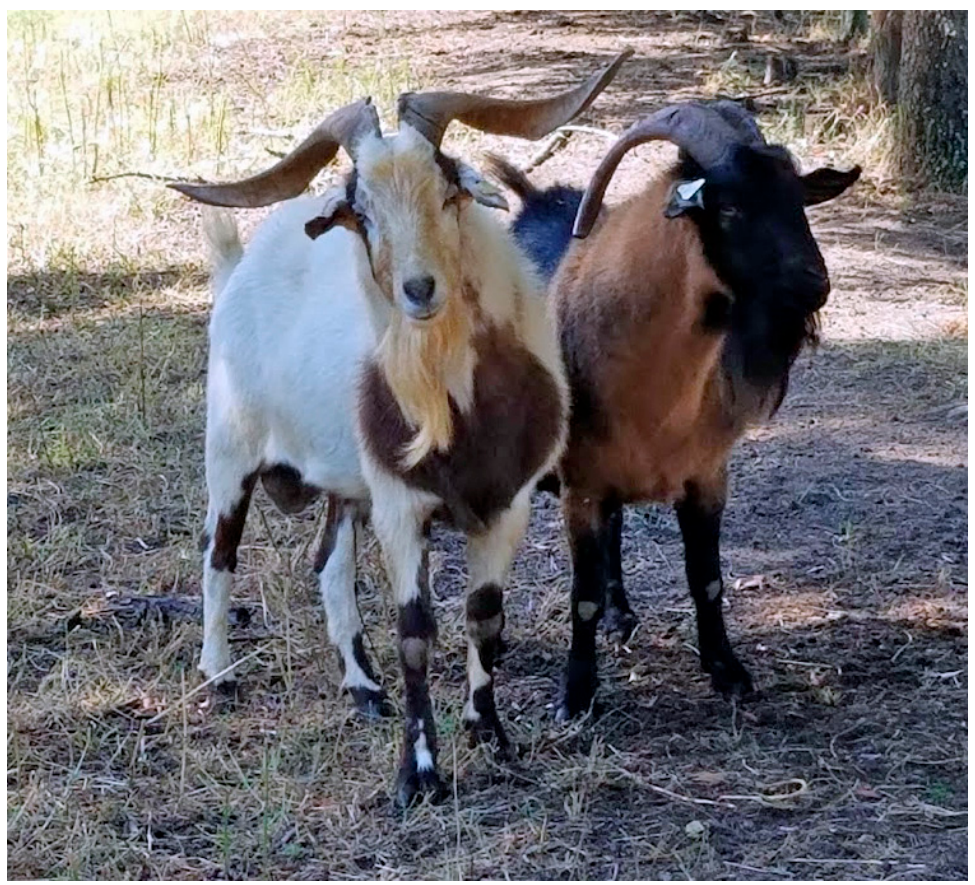
Figure 1. American Spanish goats. Mature bucks. Photo by D. Askew.